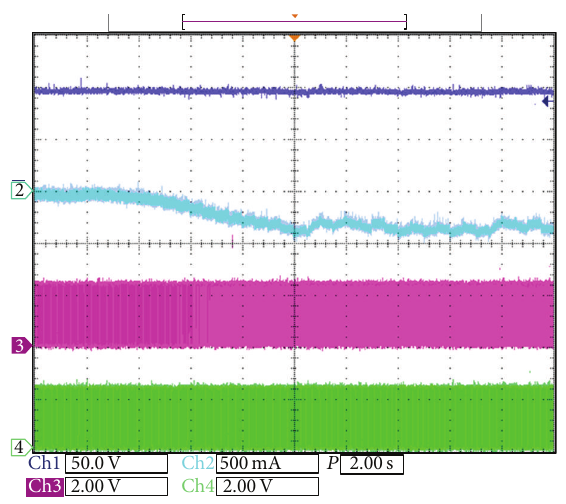
Figure 18: Operation when battery set charging starts from top to , 𝑆 2 , and 𝑆 1 bottom: 𝑉 𝑜 , −𝐼 𝐿 2